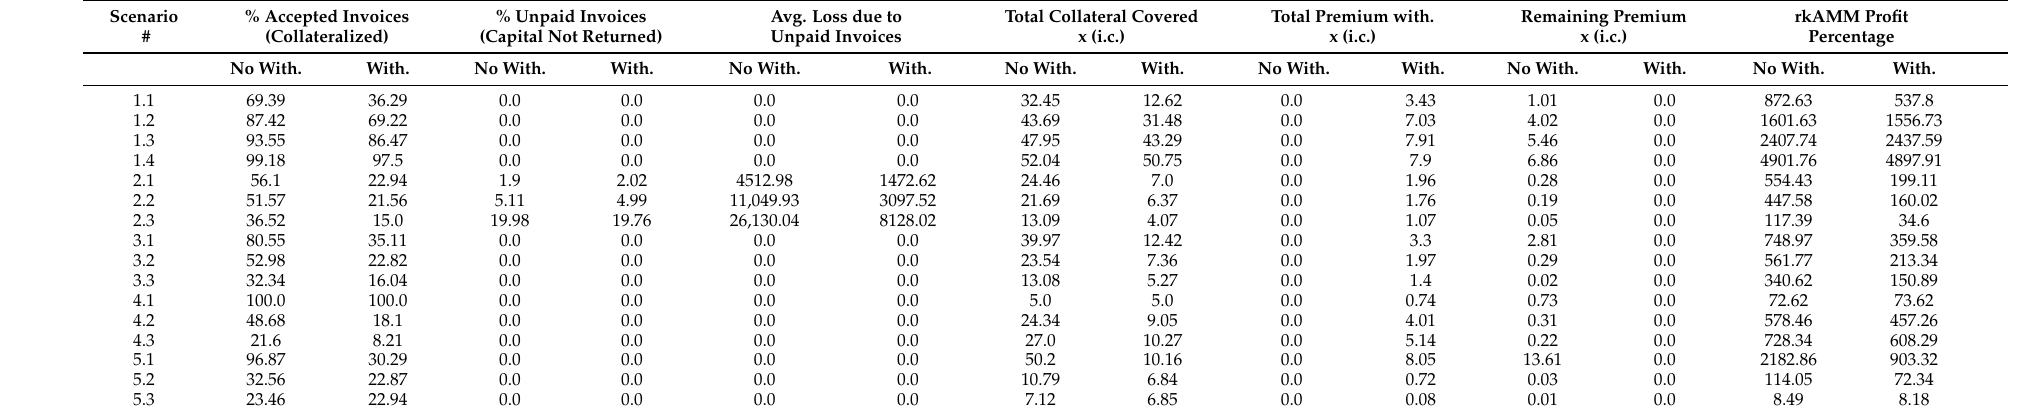
Table 9. rkAMM results. Every day, 50% of the premium obtained is withdrawn.